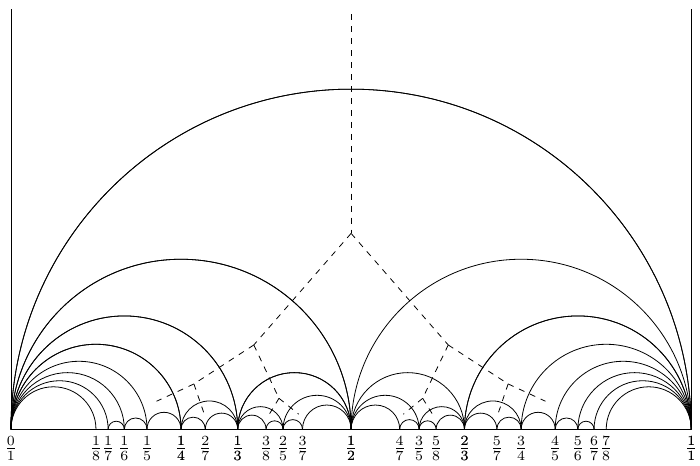
Figure 2. Options for downward decay